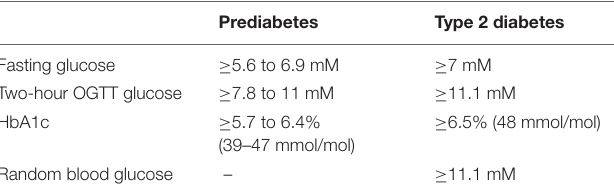
TABLE 1 | Diagnostic references range values for high risk for diabetes (prediabetes) and type 2 diabetes (American Diabetes Association,